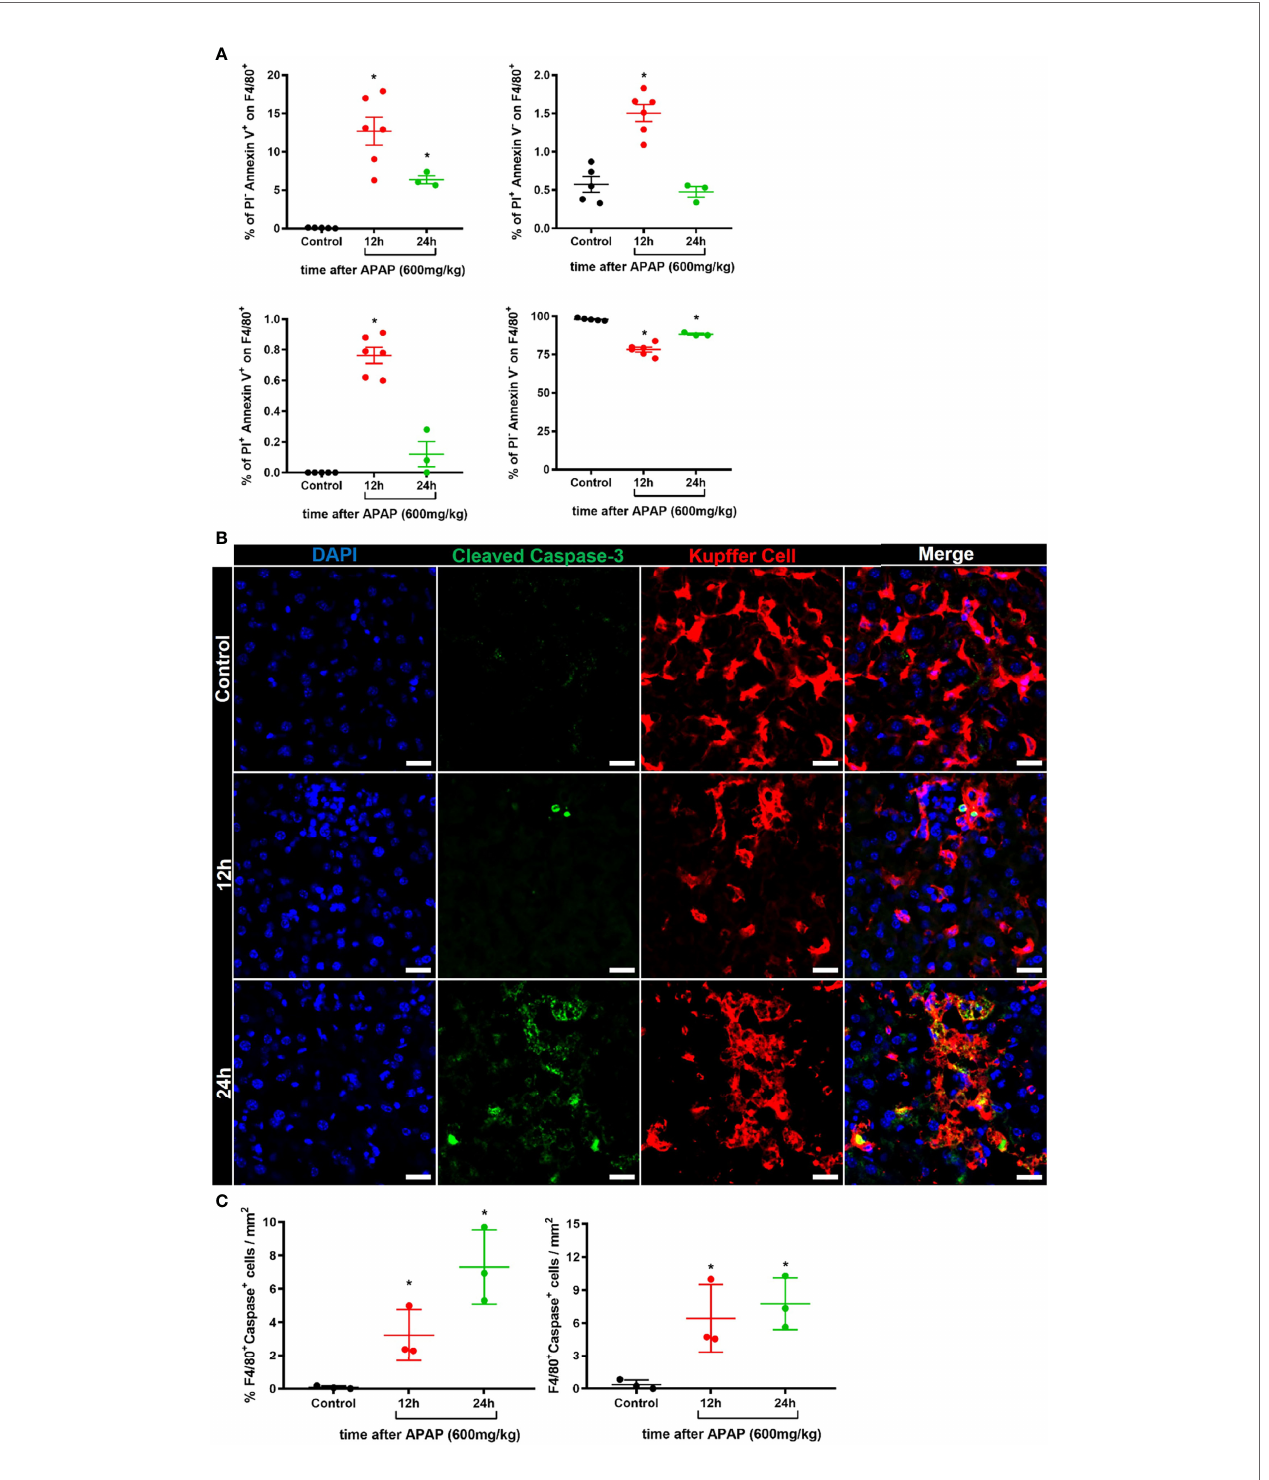
FIGURE 3 | Kupffer cell disappearance occurs by induction of an apoptotic and cell death program during ALI. (A) Percentage of different Kupffer cell status of cell death: apoptosis (Upper left, Annexin V + PI - ), necrosis (Upper right, Annexin V - PI + ), necroptosis (Bottom left, Annexin V + PI + ), and live cells (Bottom left, Annexin V - PI - ); n ≥ 3 mice per group; Representative of 2 independent experiments. (B) Representative immuno fl uorescence images of liver sections stained for DAPI (Blue), Cleaved Caspase 3 (Green), and Kupffer cell (Red, anti-F4/80); scale bar = 20µm. (C) Quanti fi cation of the percentage (Left panel) and number (Right panel) of F4/ 80 + Caspase-3 + Kupffer cells in liver sections; n ≥ 3 mice per group and 10 images per mice. Data are presented as mean ± SEM. * indicates statistical difference compared to the control group using one-way ANOVA followed and Tukey post-test (* = p <